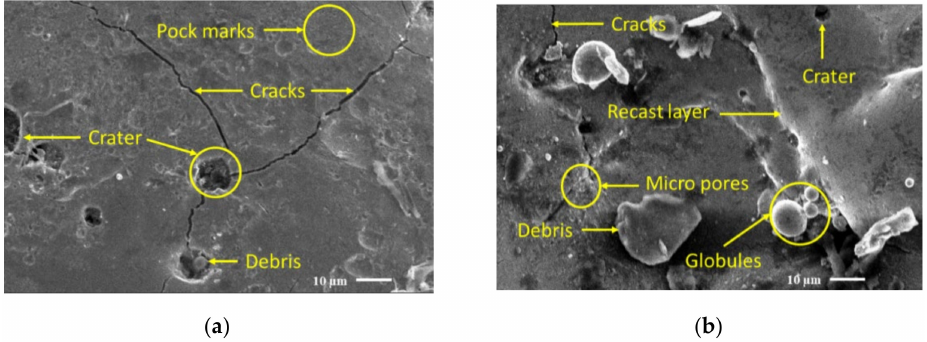
Figure 8. Variation of surface morphology with I p (I p , V g , T on , T off , P) ( a ) (6, 60, 300, 30, 16); ( b ) (10, 60, 300, 30, 16) units per Table 2.